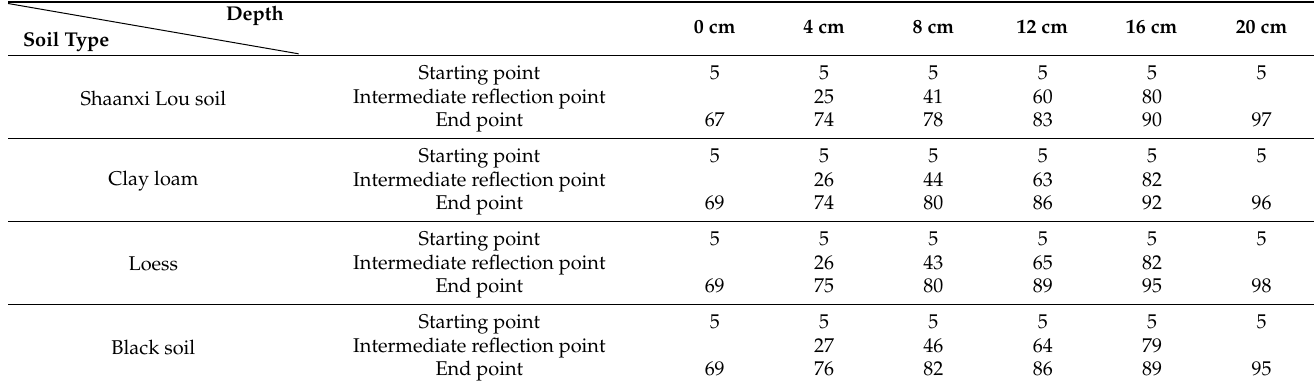
Table 2. The position of the starting point, intermediate reflection point, and the end point of the four soils with different depth of infiltration lines.